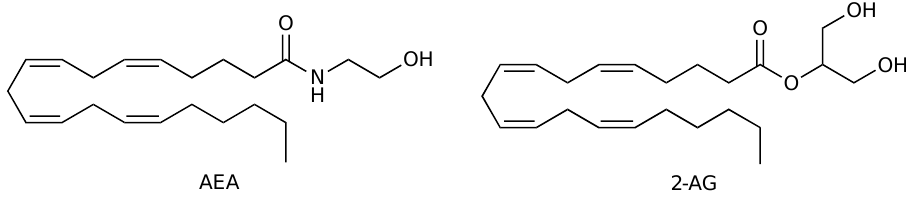
Figure 1. Chemical structures of AEA and 2-AG.